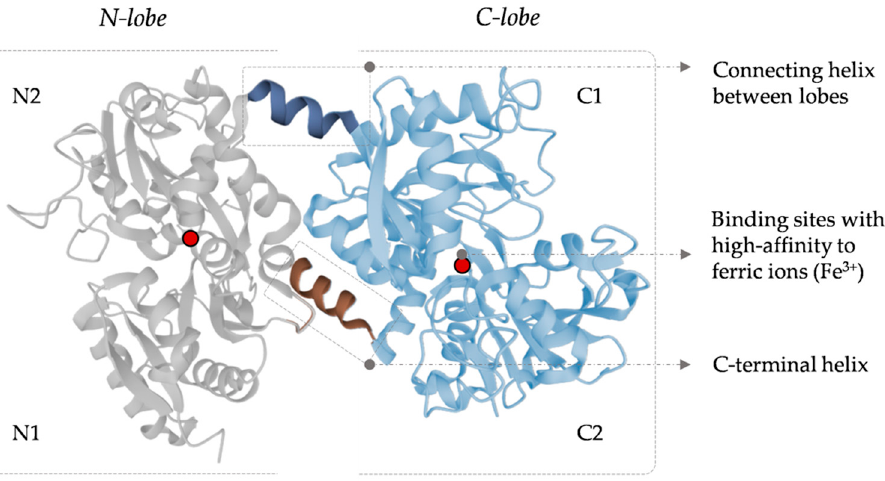
Figure 1. Human LF secondary and tertiary structures. Self-created figure using Uniprot elements (free access at https://www.uniprot.org (accessed on 27 February 2023)).